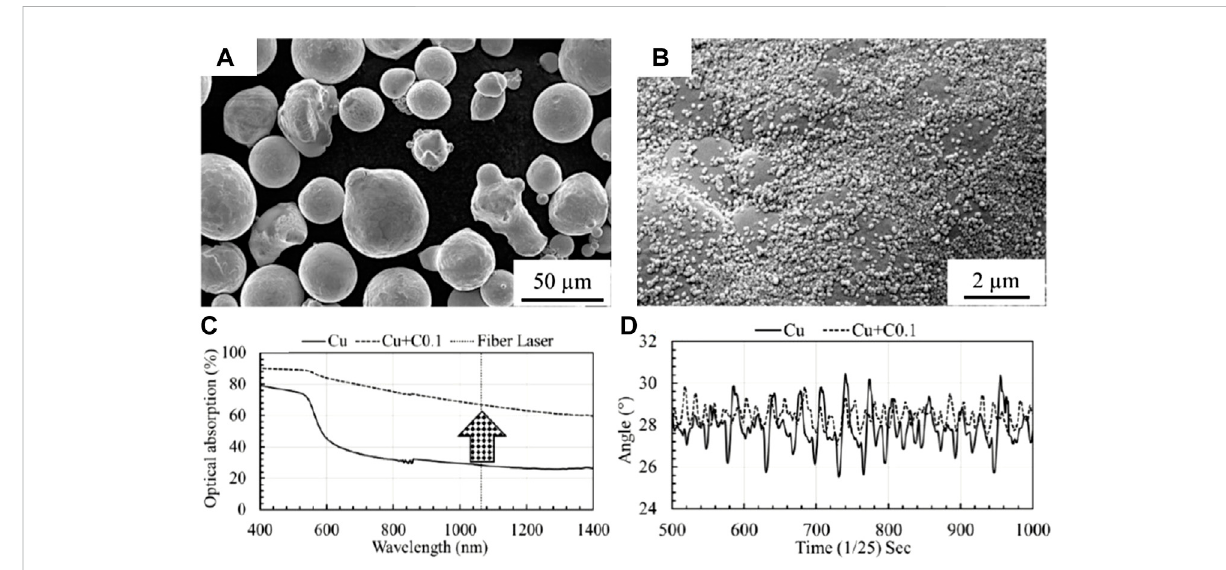
FIGURE 13 (A) SEM images of as-received copper particles, (B) surface detail of a Cu particle dry coated with carbon nanoparticles, (C) absorption of pure copperand0.1 wt%carbon-mixed-copperand (D) temporalevolutionoftheavalancheangleobservedforthesepowdersystems.Reproducedfrom Jadhav et al. (2019) under the CC BY 4.0